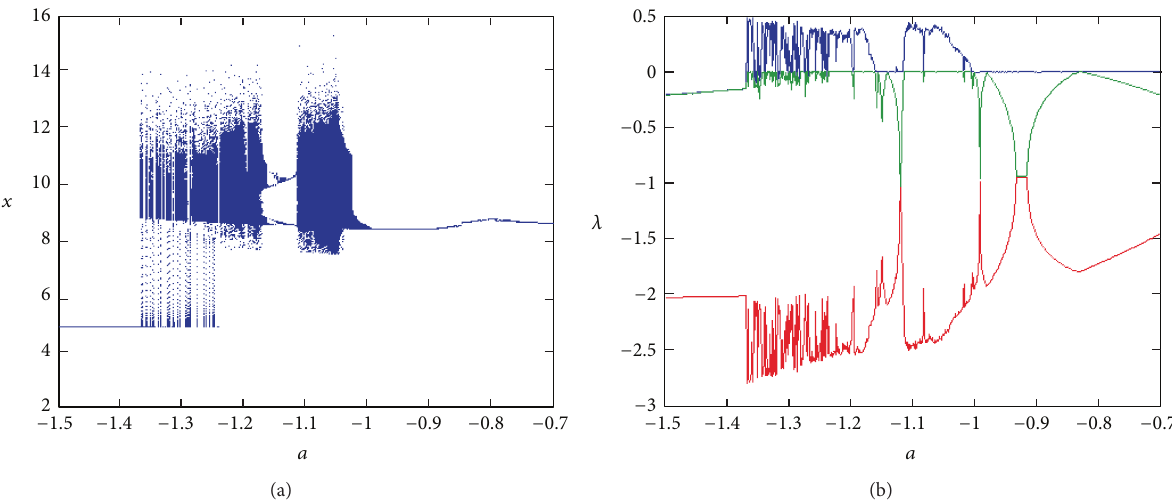
Figure 4: Nonlinear dynamics of system (1) for specific values 𝑏 = 25 versus the control parameter 𝑎 . (a) Bifurcation diagram of 𝑦 ; (b) Lyapunov exponent